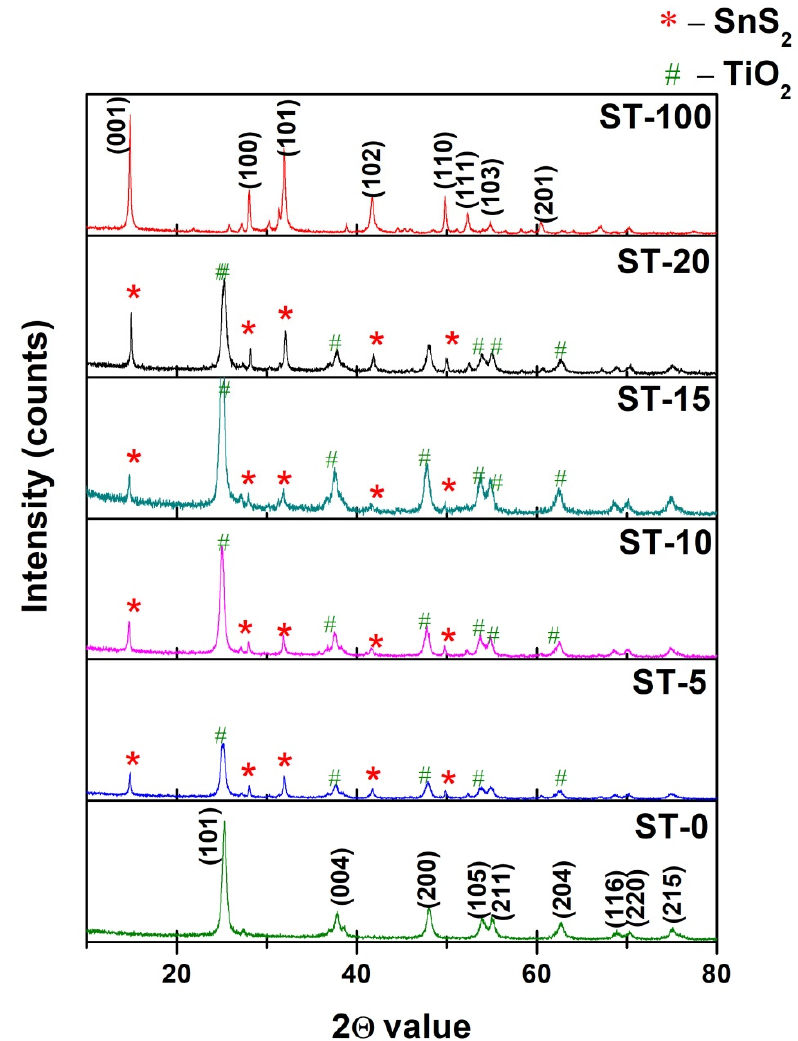
Figure 1. XRD for pristine TiO 2 (ST-0), SnS 2 (ST-100), and X wt. % of SnS 2 /TiO 2 (ST-5, ST-10, ST-15, and ST-20) nanocomposites.